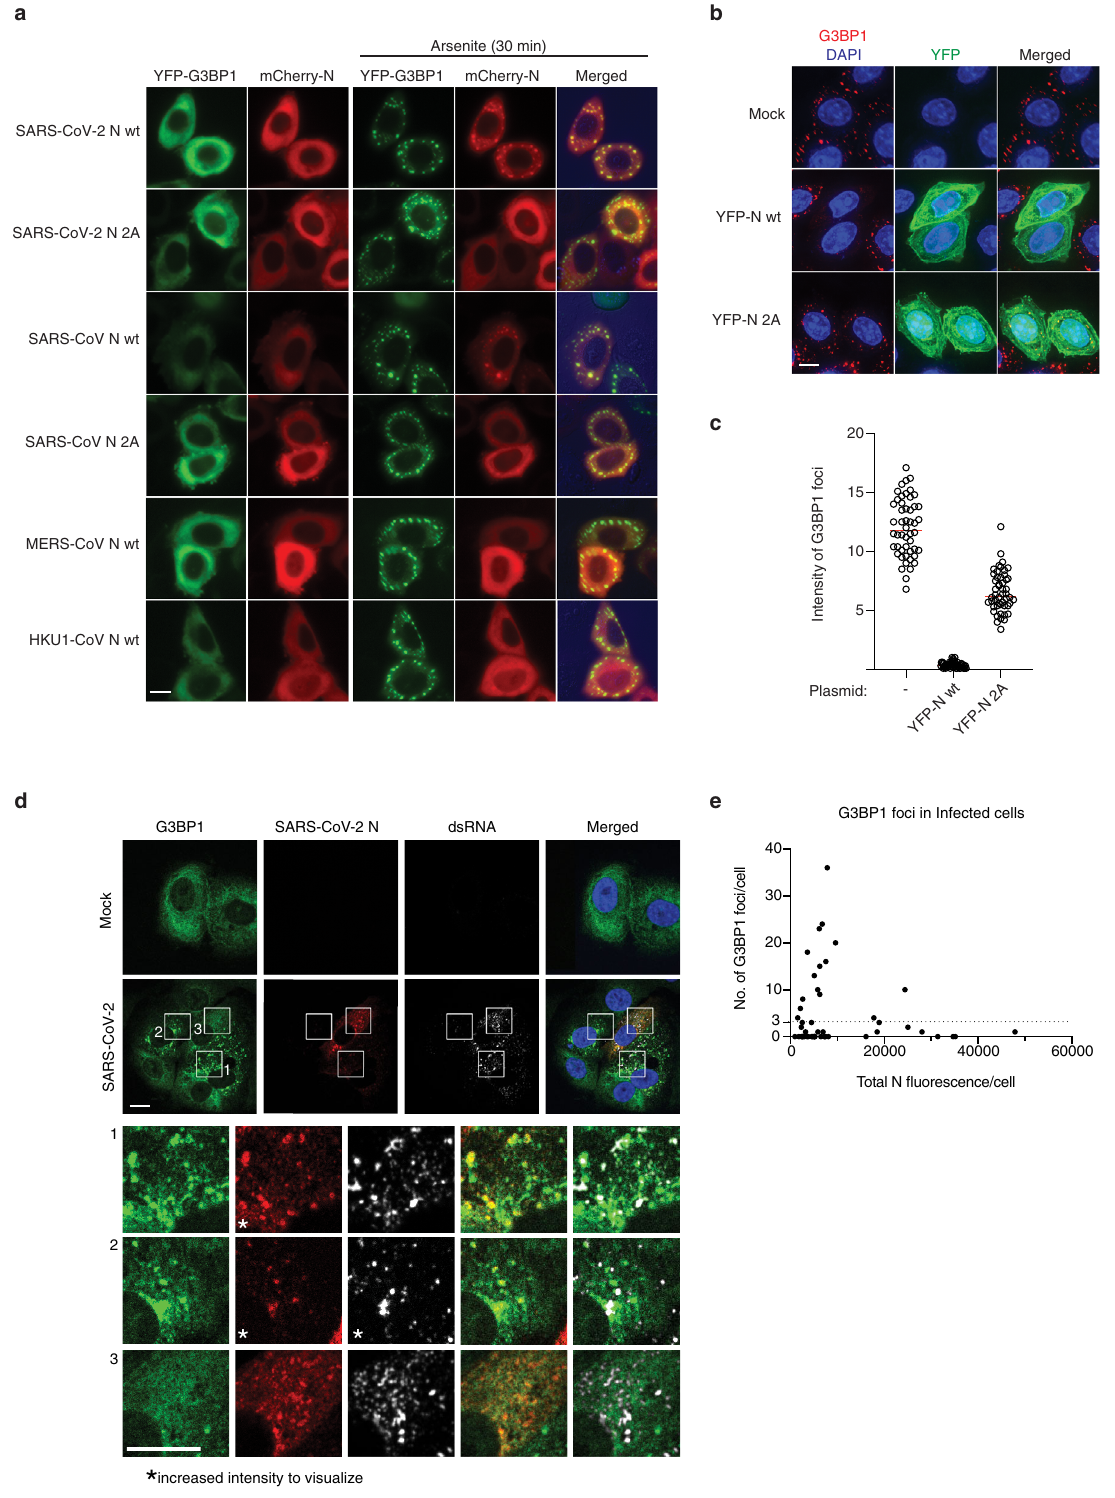
Fig. 3 Interaction between SARS-CoV-2 N and G3BP1/2 affects stress granule formation. a Live cell microscopy analysis of HeLa cells co-transfected with YFP-G3BP1 and mCherry tagged N proteins from the viral strains indicated. b Effect of SARS-CoV-2 N wt and N 2 A on arsenite-induced stress granule formation as measured by immuno fl uorescence of endogenous G3BP1. c Quanti fi cation of G3BP1 foci intensity from b . Red bar indicates median intensity, and each circle represents the intensity of one G3BP1 foci. At least fi ve foci from 10 cells were measured. d Immuno fl uorescence analysis of G3BP1, N and viral dsRNA in SARS-CoV-2 infected VeroE6 cells 6 h postinfection. e Effect of N levels on G3BP1 foci formation in SARS-CoV-2 infected cells. Each circle represents one cell analysed automatically from one experiment done in duplicate ( n = 51). Microscopy images shown are representatives of three independent experiments for a and b . Scale bars are 10 μ M. Source data are provided as a Source Data fi